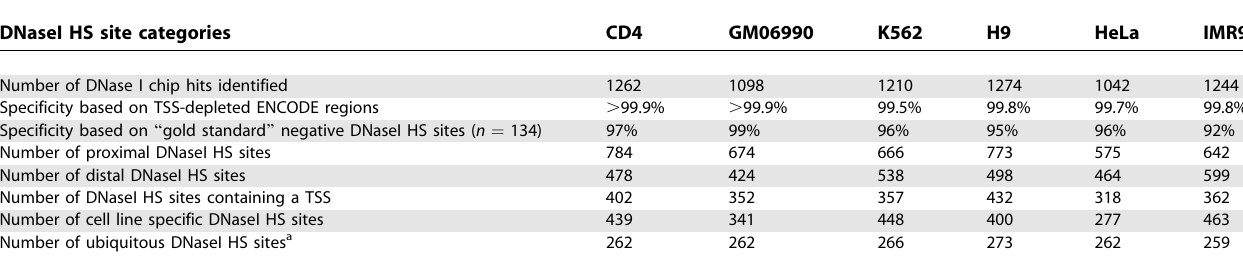
Table 1. DNase-Chip Statistics for Different Cell Lines DNaseI HS site